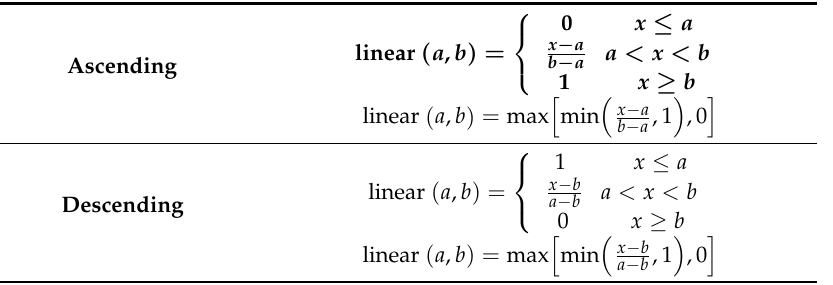
Table 2. Fuzzy membership functions used in the